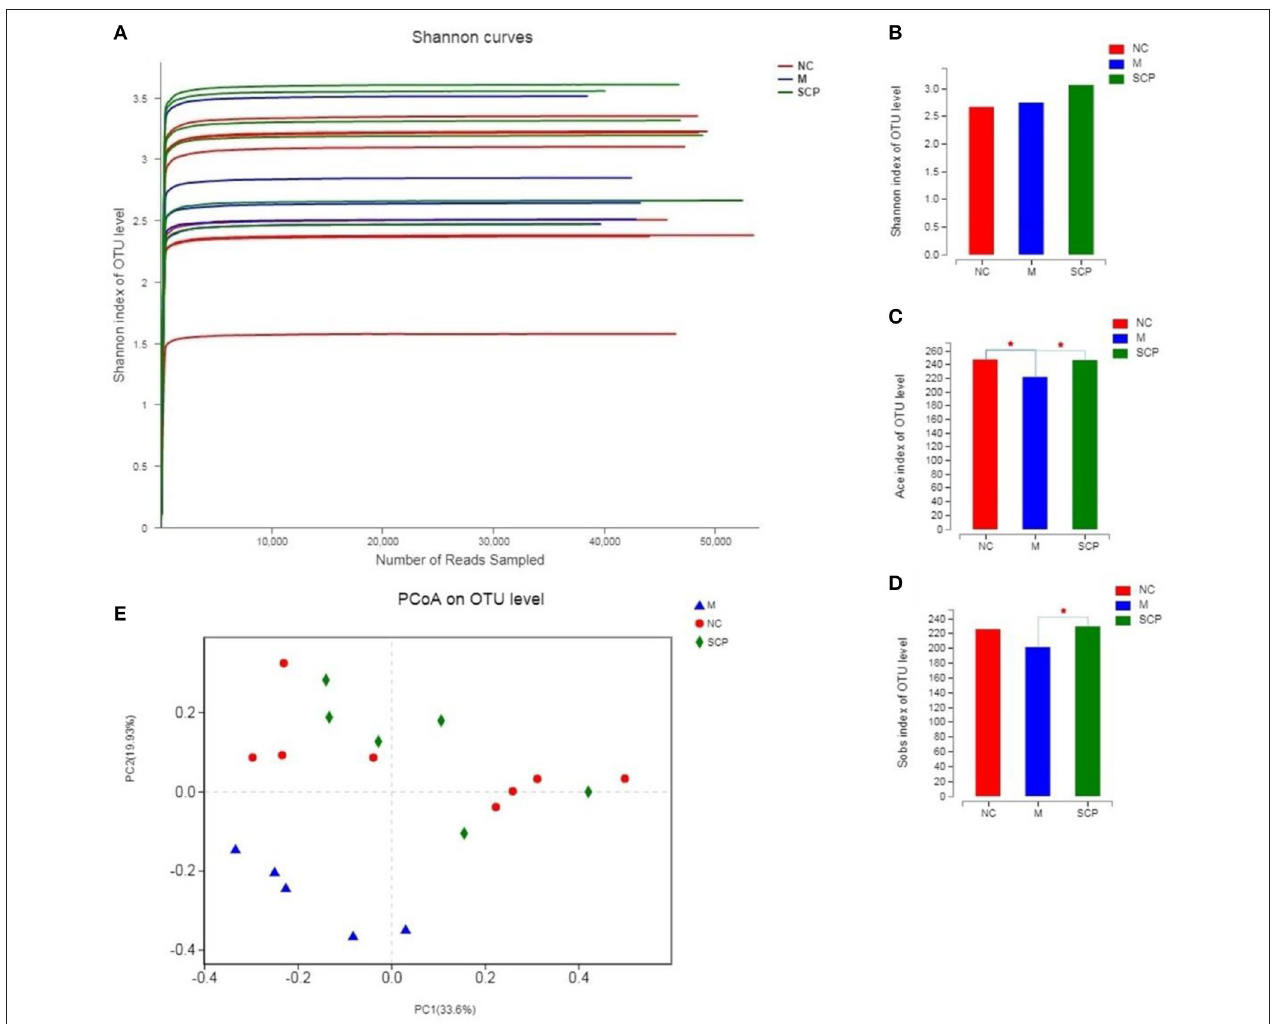
FIGURE 6 | α and β Diversity analysis of the gut microbiota. (A) Rarefaction curves. (B) Sobs analysis. (C) Ace index. (D) Shannon index. (E) PCoA score plot. NC, control group; M, DSS group; SCP, S. chinensis polysaccharide group. Values are expressed as means ± S.D. Graph bars marked with different letters represent statistically significant results ( p < 0.05) based on ANOVA with Duncan’s range tests, whereas bars marked with identical letters represent no statistically significant